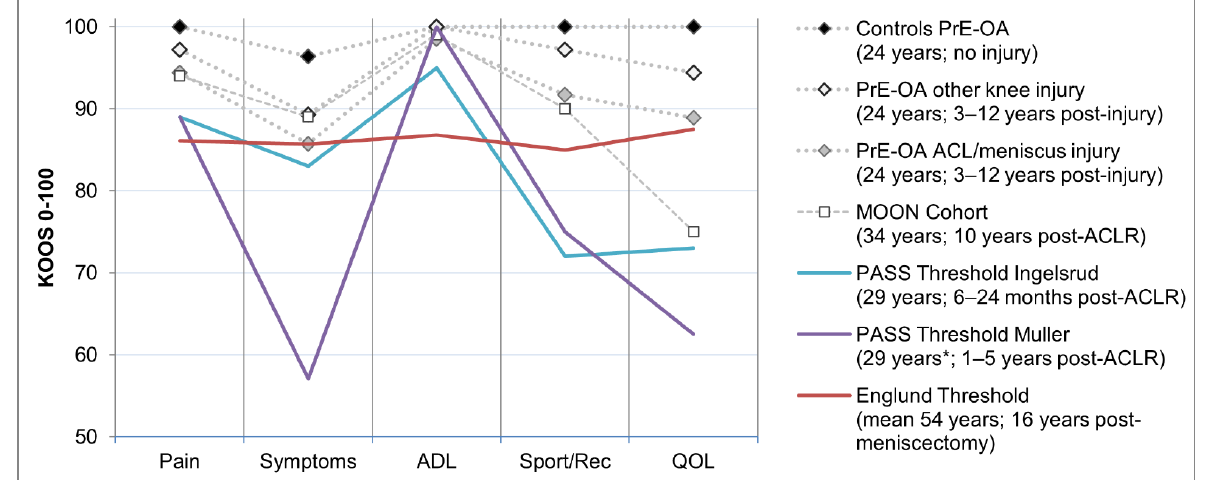
ADL, activities of daily living; IQR, interquartile range; KOOS, knee injury and osteoarthritis outcome score; N/A, not applicable; QOL, quality of life; Sport, sport and recreation; Sym, symptoms. * Proportion that did not have a “symptomatic knee” based on Englund criteria of meeting QOL subscale threshold and at least 2 other subscale thresholds.